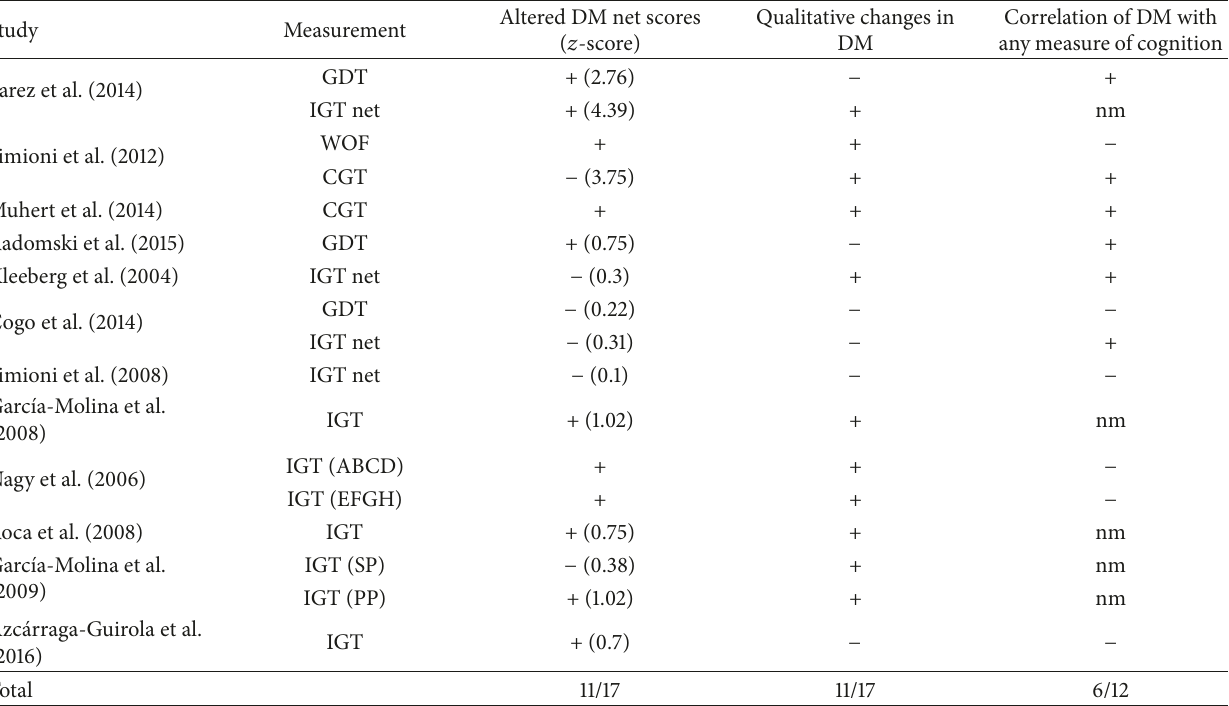
Table 3: Decision-making performance in MS patients compared to HCs and correlations with other cognitive domains. Study